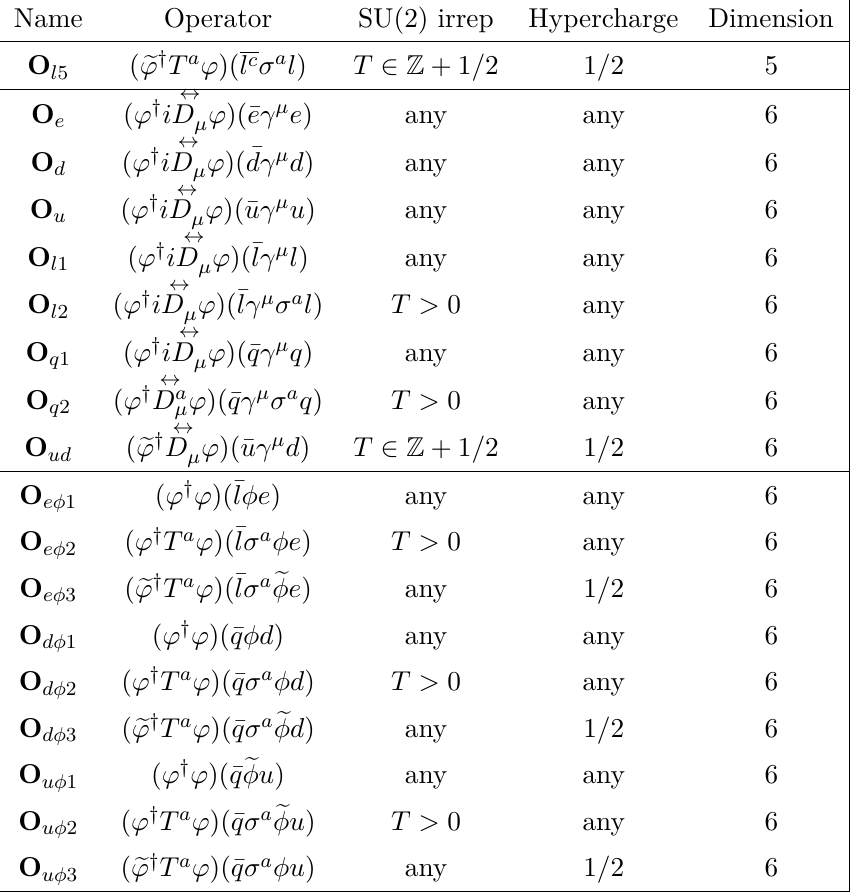
Table 5 . Basis of operators of dimension ≤ 6 with two scalar DM multiplets and at least one SM